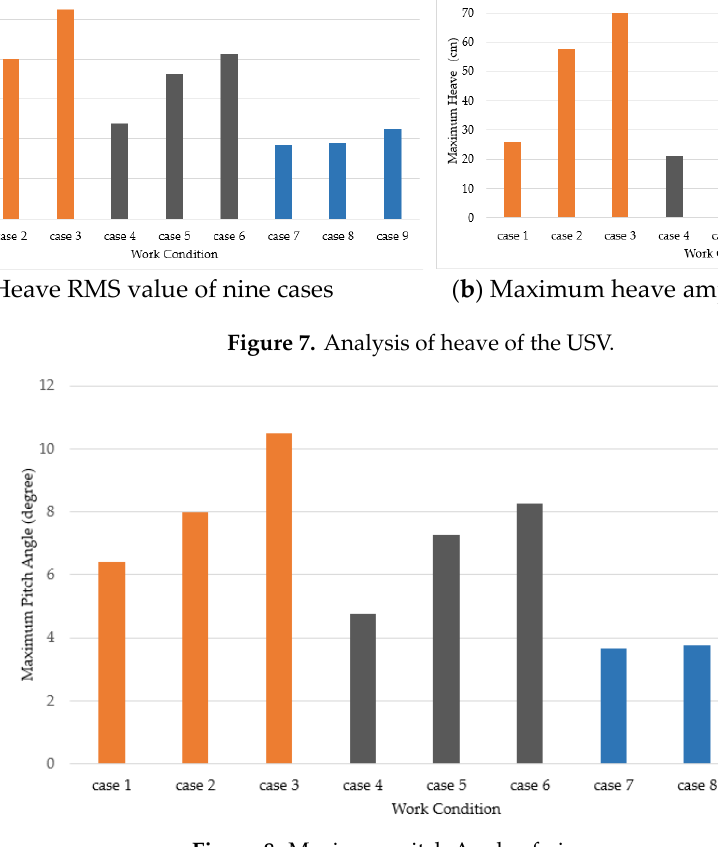
Figure 8. Maximum pitch Angle of nine cases.